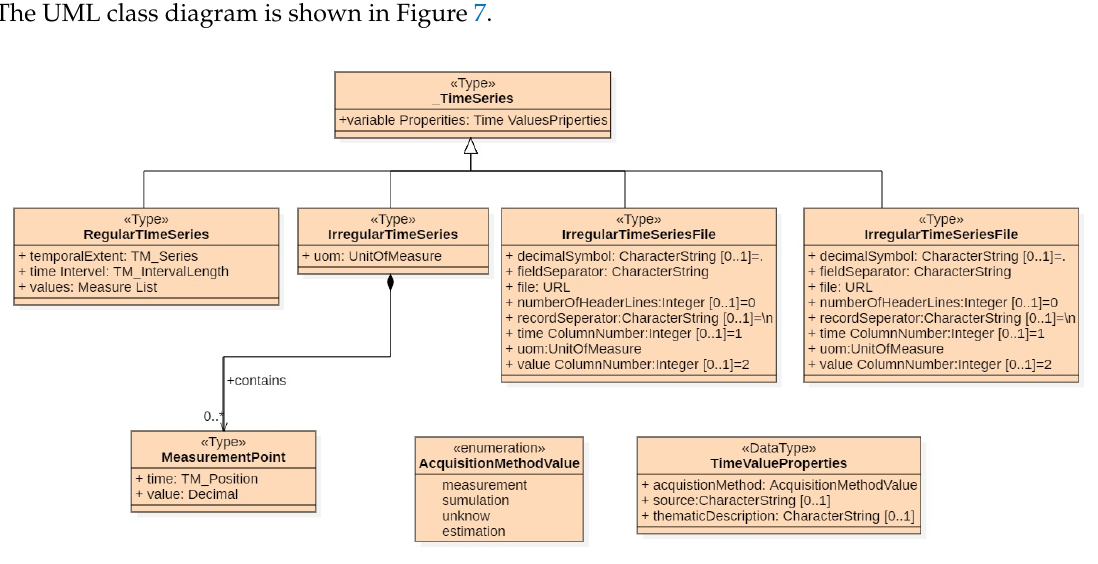
Figure 7. UML class diagram of TimeSeries.